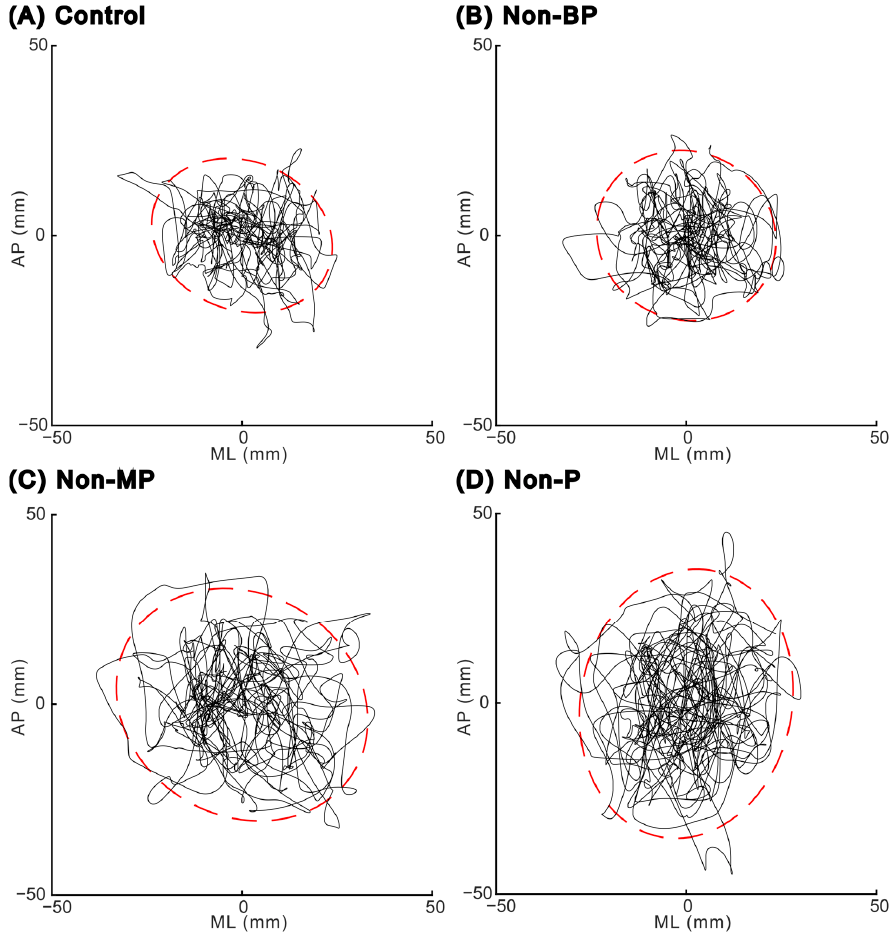
Figure 2. Center-of-pressure trajectories in the horizontal plane for one representative trial in each visual condition: ( A ) Control condition, ( B ) Non-BP condition (without binocular parallax), ( C ) Non-MP condition (without motion parallax), and ( D ) Non-P condition (without both binocular and motion parallax). Red dashed lines indicate the edge of the 95% con fi dence area of the center of pressure. AP, anteroposterior; ML, mediolateral.